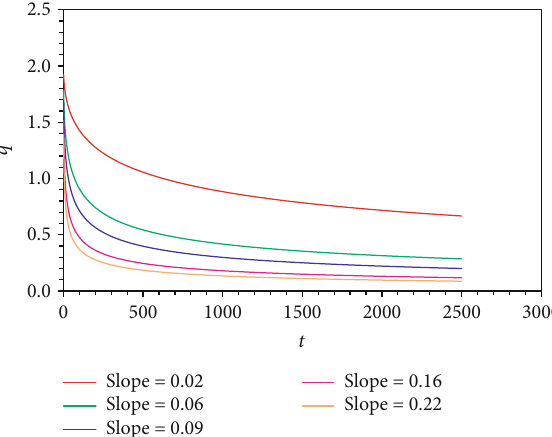
Figure 11: q vs. t matching plot for C well. g